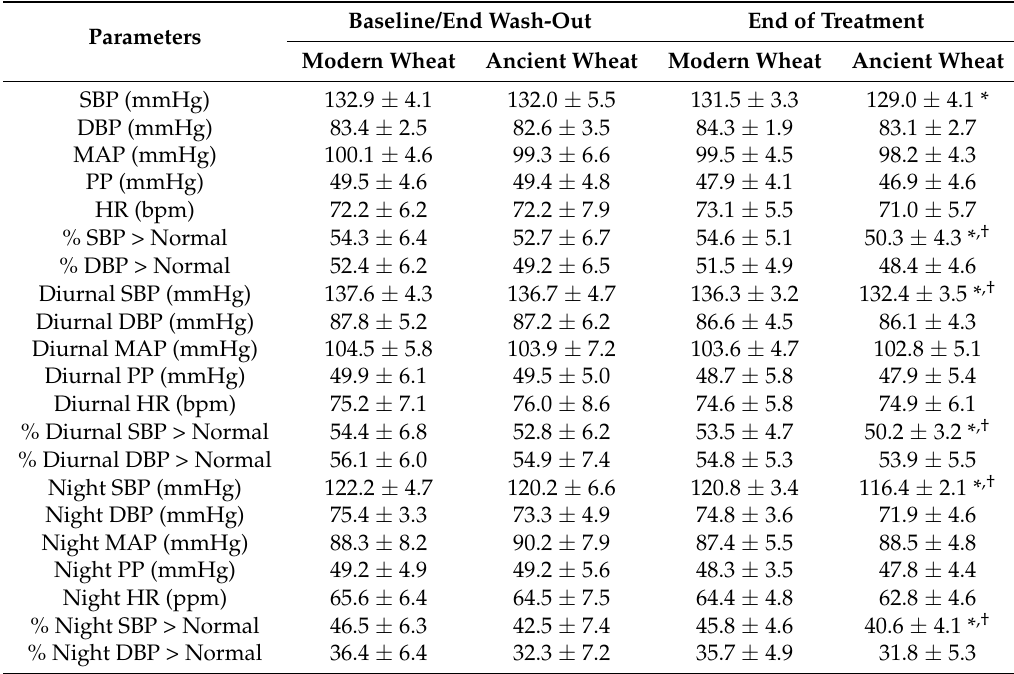
Table 6. Changes in 24 h ambulatory blood pressure monitoring (ABPM) parameters from baseline/end wash-out to end of treatment, expressed as mean ± standard deviation.